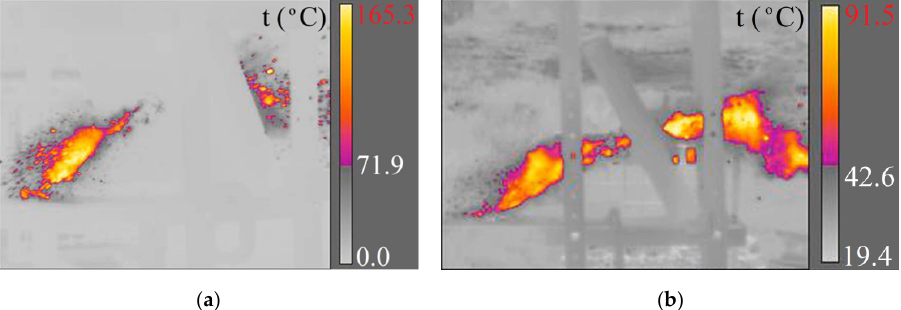
Figure 8. Piercing a concrete sidewalk slab with a 7.62 × 54R LPS projectile recorded with cameras: ( a ) X6580sc (660 fps); ( b ) A6901scSLS (2615 fps).